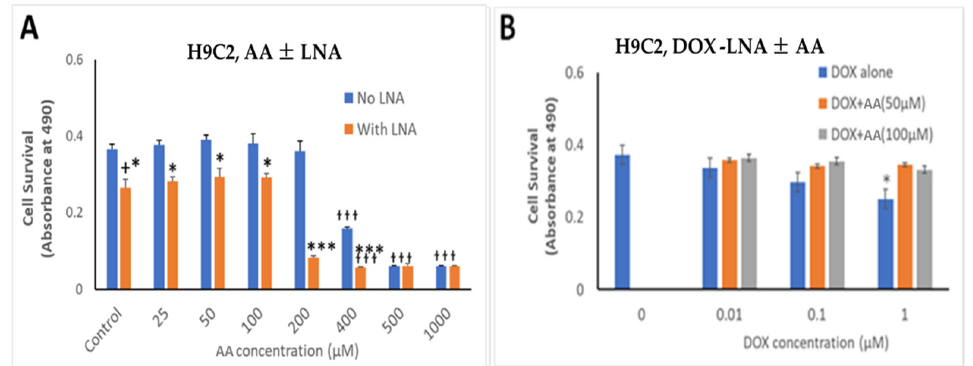
Figure 8. Effects of AA and Rlip knockdown on doxorubicin toxicity in the immortalized H9C2 cardiomyocyte cell line. H9C2 cells were transfected with Rlip-LNA or scrambled control LNA as described above. Results of MTT assay are shown in cells ( A ) treated with either Rlip-LNA or scrambled control and AA at 25–1000 µ M or ( B ) with 1 µ M dox with 50 or 100 µ M AA. After 24 h, cells were analyzed for survival by MTT assay. The expressed values are means ± SD (n = 3 independent experiments with eight replicates). + p < 0.05, no LNA vs. LNA control; * p < 0.05, *** p < 0.001, comparison of AA treatments between no LNA and LNA; łłł p < 0.001, comparison between AA treatments with their corresponding controls (0), as analyzed by a two-tailed Student t -test.